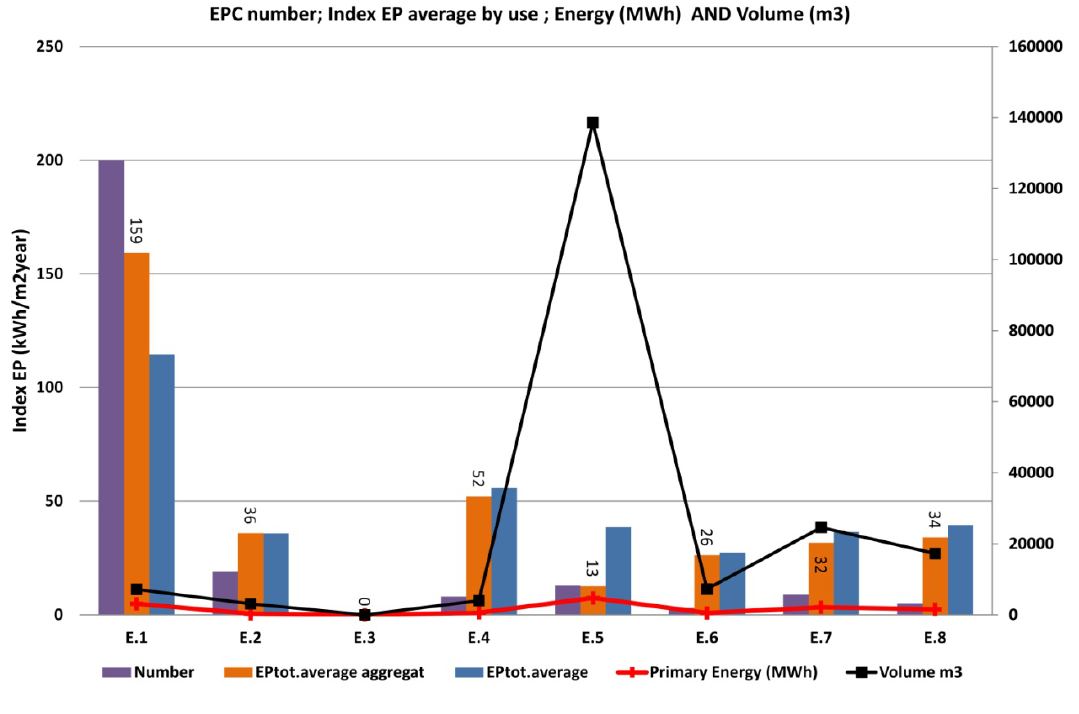
, primary energy (MWh) and tot